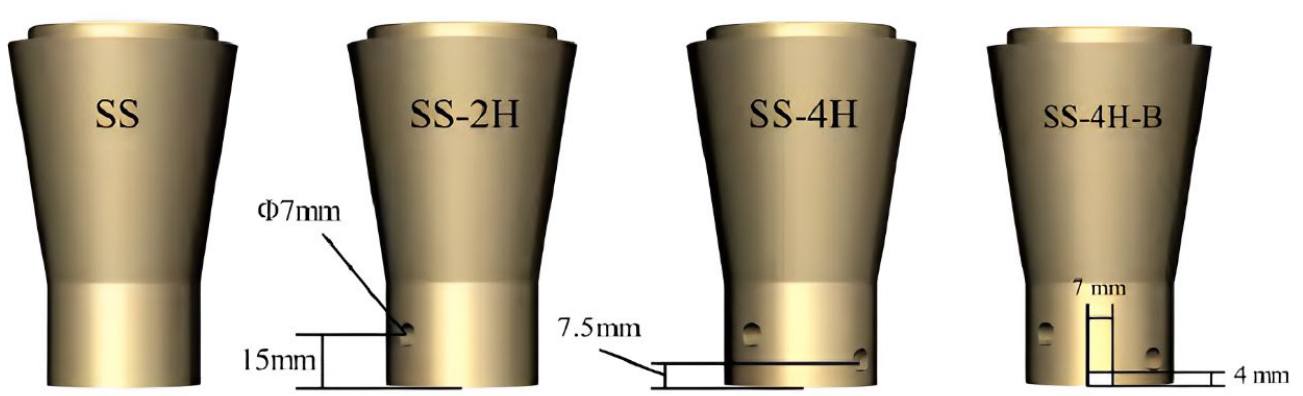
Figure 18. Structure drawing of different runner cone [74].